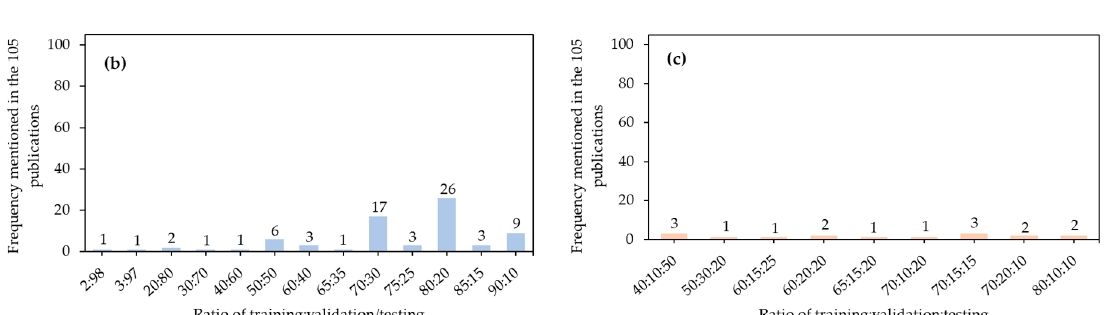
Figure 8. Frequency of development strategies in the 105 publications. ( a ) Frequency of the two development strategy; ( b )